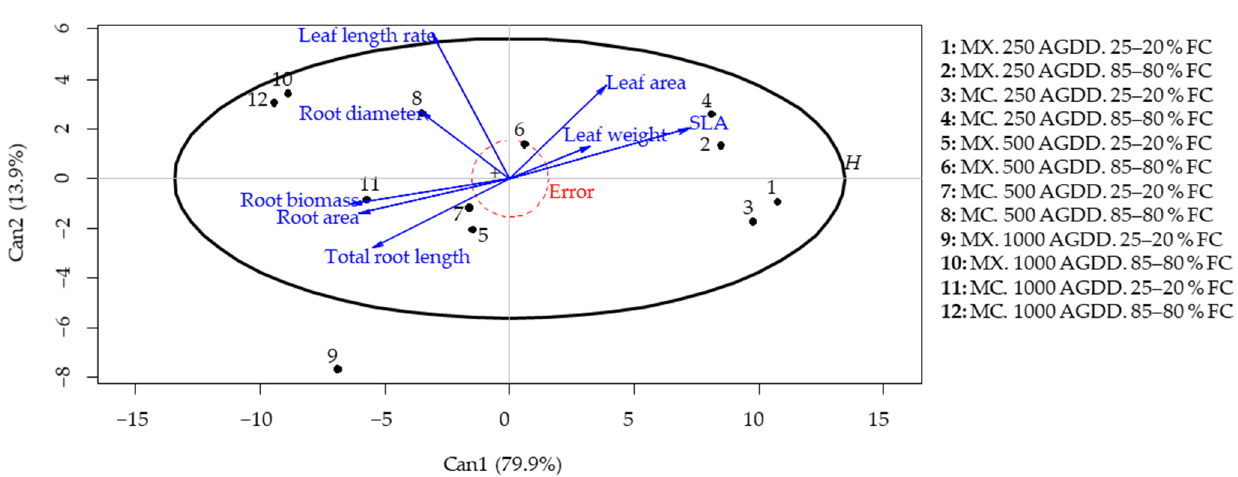
Figure 2. Changes in morphological variables and their relationships for Bromus valdivianus grown under two pasture types (monoculture (MC) and in a 50/50% mixture with Lolium perenne (MX)), and subjected to three levels of defoliation frequency (250, 500 and 1000 accumulated growing degree days (AGDD)), and two levels of soil water content (80–85% and 20–25% of field capacity (FC)). The size of the null hypothesis ( H ) ellipsis relative to the error ellipsis (within-group variance) is an indication of the magnitude of the multivariate effect of the group mean.